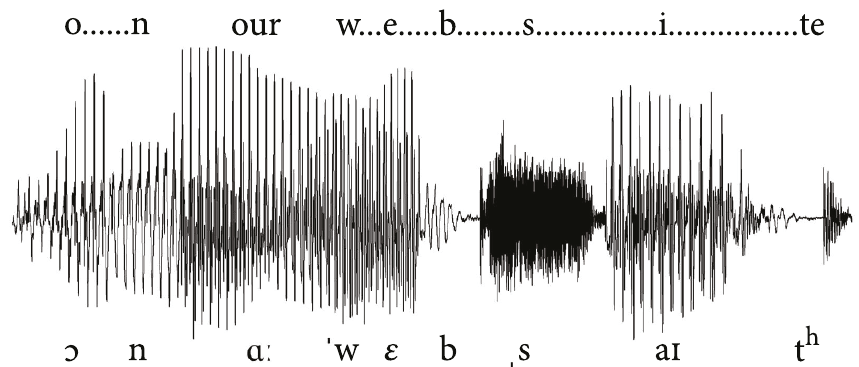
Figure 13: Waveform for the spoken phrase “On our website” with an alphabetic transcription above the waveform and a phonetic transcription below it. With thanks to Sidney Wood of SWPhonetics (swphonetics.com) for the figure and for permission to reproduce